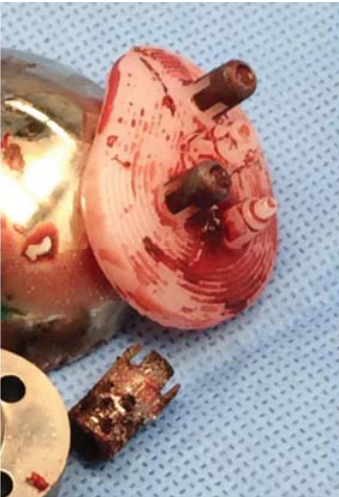
Figure 3: Explanted glenoid component. Note that one of the pegs and the cage have dissociated from the remainder of the glenoid